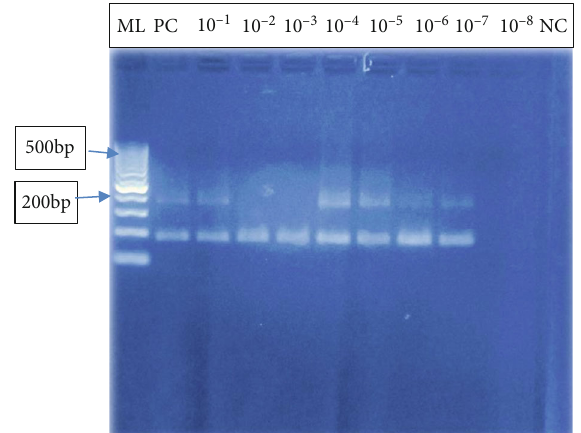
Figure 7: PCR sensitivity testing on gel electrophoresis. Lane ML: molecular marker 100bp; lane PC: positive control, W. bancrofti DNA; lanes 10 − 1 – 10 − 7 : serial dilutions of DNA extracts for testing the assay sensitivity; lane 10 − 8 : no ampli fi cation; lane NC: represents negative control; 10 − 1 – 10 − 7 showed ampli fi cation of W. bancrofti as bands appeared just below the 200bp as the expected band size was 188bp. This showed that PCR assay was sensitive and could detect to up to 1/1000000 (1/10 7 ) copies of parasite DNA in the diluent, while no band was observed in 1/10000000 (1/10 8 ) copies in the